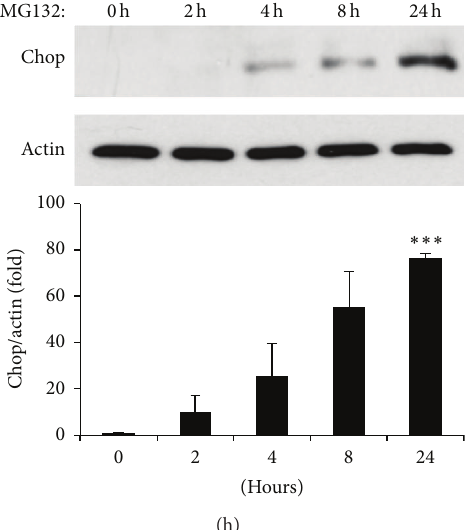
Figure 3: UPS inactivation induces ER stress in 𝛽 -cells. ((a)–(f)) MIN6 cells were treated with 0.5 mM palmitate ((a), (c), and (e)) or 10 𝜇 M MG132 ((b), (d), and (f)) and ER stress markers (ATF4, Chop, and Bip) measured as indicated. RNA was isolated using NucleoSpin RNA XS kit and cDNA was made with a High Capacity cDNA Reverse Transcriptase Kit. mRNA was analysed via real-time PCR analysis and standardised to 𝛽 -actin internal control levels. ((g)-(h)) MIN6 cells were treated with 0.5 mM palmitate (g) or 10 𝜇 M MG132 (h) as indicated, and levels of Chop protein expression were measured by Western blot. Band intensities were quantified and standardised to 𝛽 -actin loading control. Results are the means ± SEM of 3–5 independent experiments. ∗ 𝑃 < 0.05 , ∗∗ 𝑃 < 0.01 , and ∗∗∗ 𝑃 < 0.001